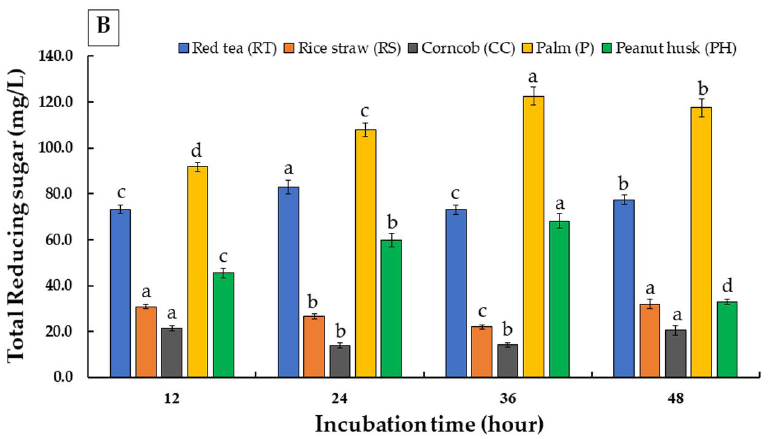
Figure 7. Phosphorus ( A ) and total reducing sugar ( B ) content of crude enzyme extract obtained from Thermoascus aurantiacus SL16W using different substrates: red tea, rice straw, corncob, palm residue, and peanut husk. Different letters in the same column are considered significantly different according to Duncan’s multiple comparison test ( p ˂ 0.05).